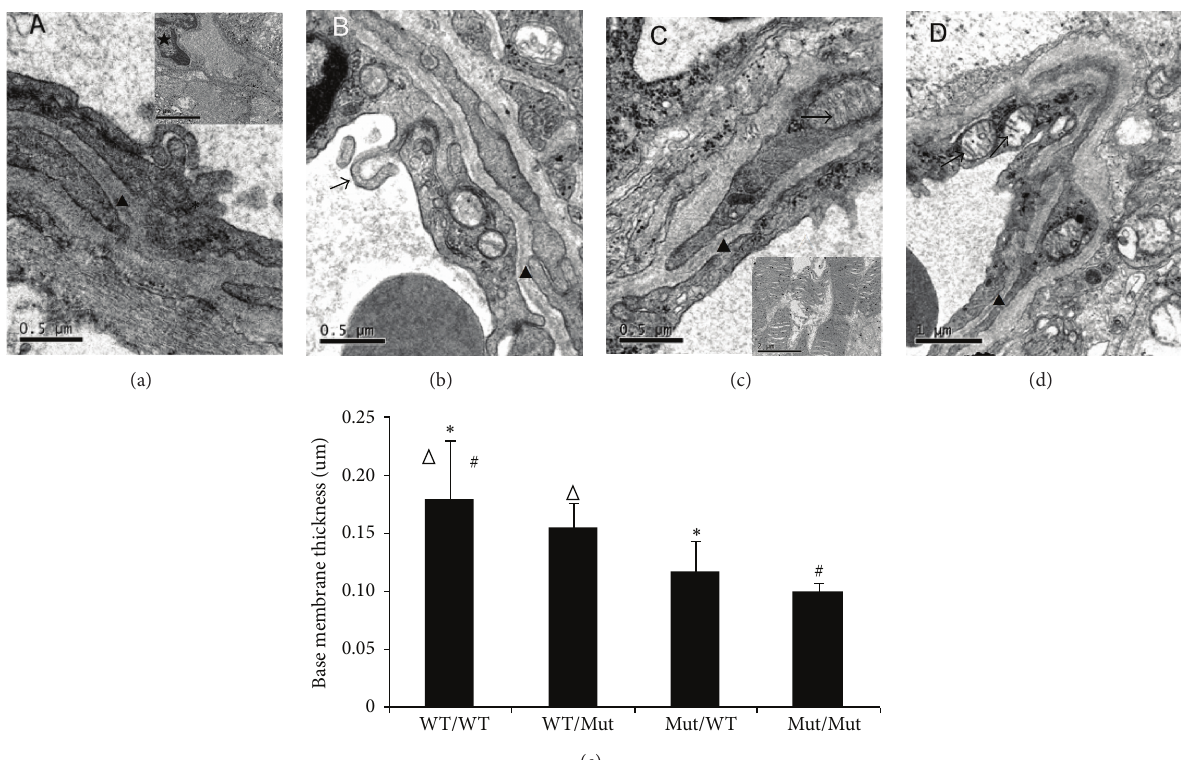
Figure 2: Ultrastructural signs of the blood retina barrier. (a to d) Representative electron micrographs of the retinal capillary ultrastructure from the inner layer are shown. (a) Capillary from the WT/WT (donor/recipient) group, showing a thick BM (0.18 𝜇 m, arrowhead) with pericyte edema ( ∗ ); inset, monocyte infiltration in the retinal tissue ( 󳀅 ). (b) Capillary from the WT/Mut group. Protrusion of some villi into the lumen in endothelial cells (arrow). Reduced thickening of the basal membrane (0.15 𝜇 m, arrowhead). (c) Capillary from the Mut/WT group, showing a relatively thin BM (0.12 𝜇 m, arrowhead). Part of the crest of the mitochondria is shortened (arrow); inset, the obvious swelling of the mitochondrial crest. (d) Capillary from the Mut/Mut group, showing a thin BM (0.10 𝜇 m, arrowhead). The structure of the mitochondria is intact (arrow, magnification is indicated by the bar in the figure, 𝑛 = 3 mice/group). (e) Vascular basement membrane thickness was measured in 12 retinal vessels from each group (from three mice). Basement membrane thickness was measured at 5 locations around the perimeter of the vessel and averaged to obtain a value for each vessel. ∗ 𝑃 < 0.01 , WT/WT group compared with the Mut/WT group, # 𝑃 < 0.01 , WT/WT group compared with the Mut/Mut group, and Δ 𝑃 < 0.01 , WT/WT group compared with the WT/Mut